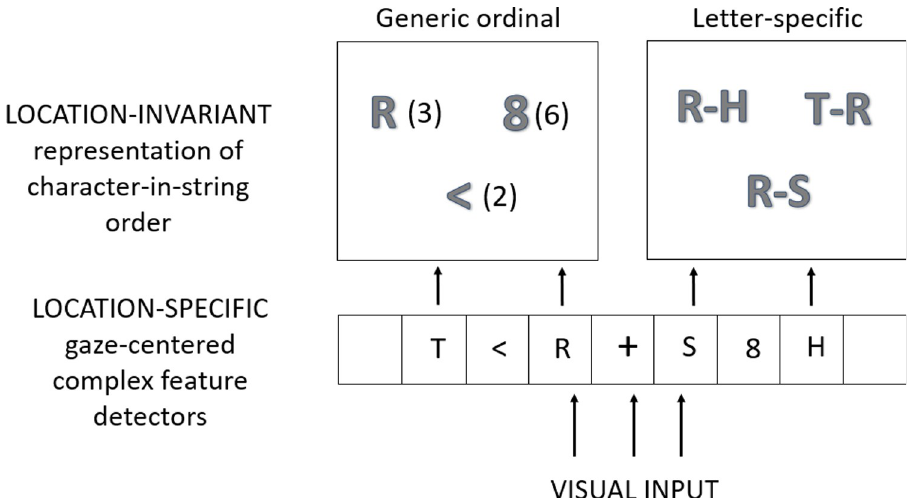
Fig 1. Theoretical framework for the processing of identity and order information for same-different matching with strings of letters, digits, or symbols. Stimuli are first encoded via location-specific gaze-centered complex feature detectors. Location-specific complex features then activate location-invariant object identities that are assigned an order in the string. Crucially, we hypothesize the existence of two different location-invariant order-encoding mechanisms: a generic order encoding mechanism, illustrated here by a simple ordinal representation (e.g., R(3), there is the letter R at the 3 rd position), and a letter-specific order encoding mechanism (open-bigram coding in the examples shown in the upper-right panel of the Figure (e.g., T-R, there is a T before an R).